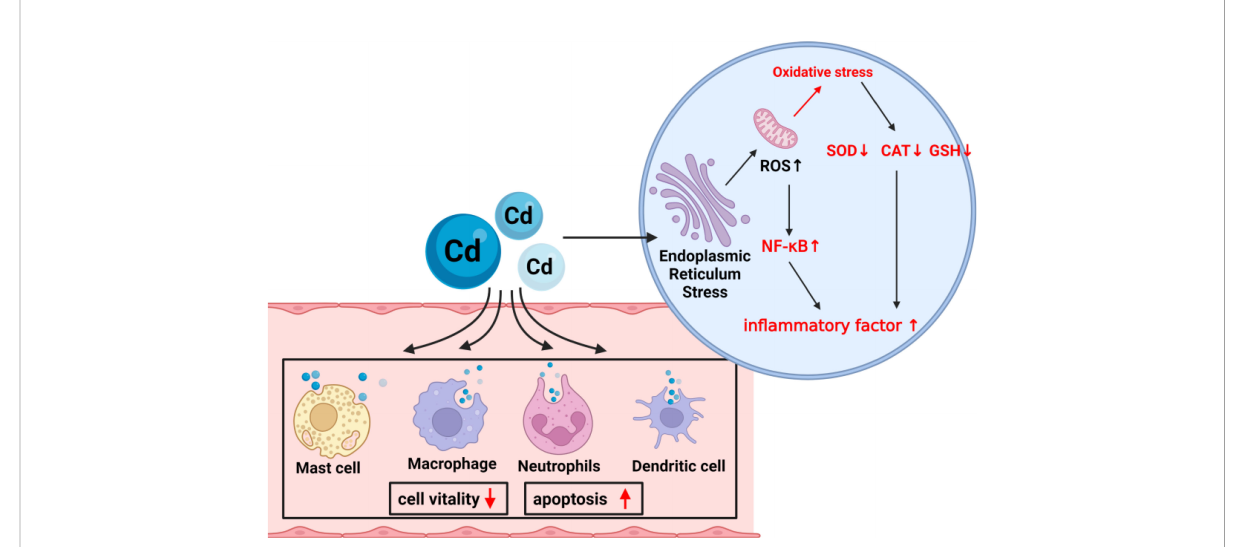
FIGURE 4 The mechanism of Cd exposure on cells. Cd exposure damages most of the immune cells in the immune system, including decreased vitality and increased apoptosis rate. Oxidative stress in cells occurs mainly through damage to the endoplasmic reticulum and